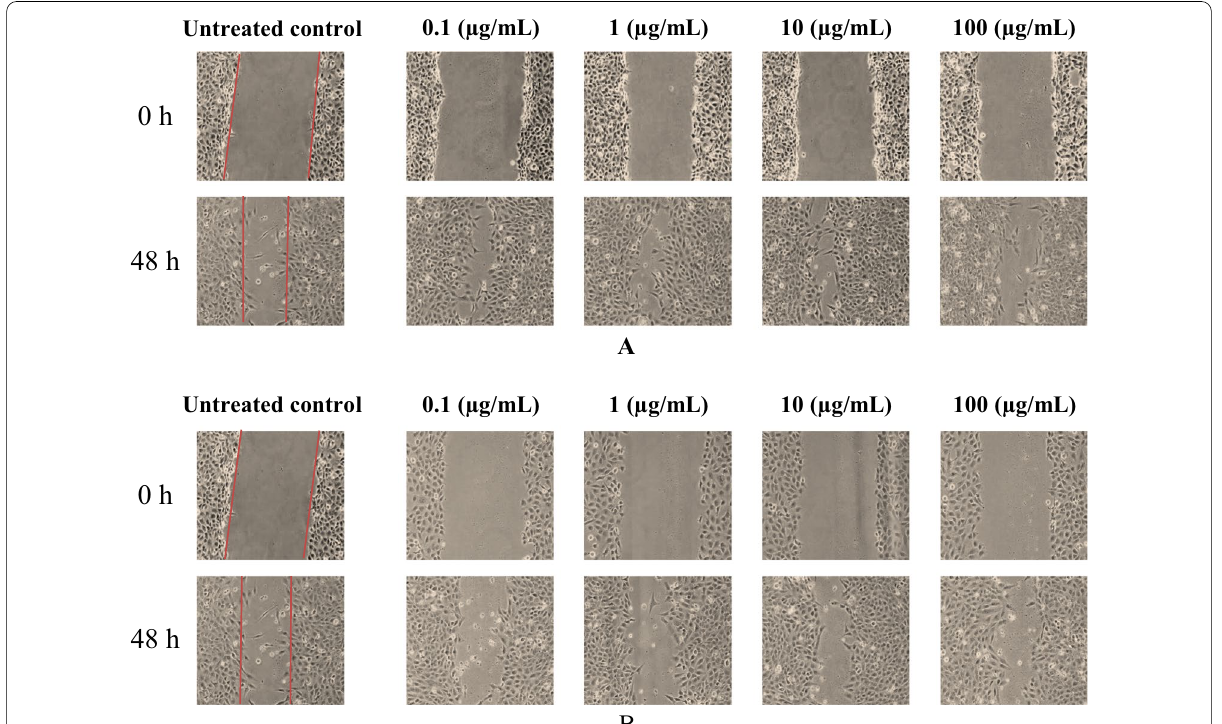
Fig. 3 Wound enclosure process stimulated by aerial parts ( A ) and root ( B ) extract at the beginning and the end of the experiments as shown in 4 ×